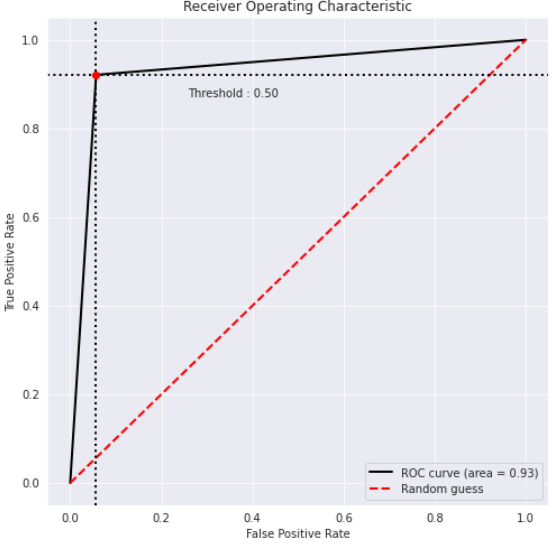
Figure 9. The ROC curve analysis of our proposed ETC approach.